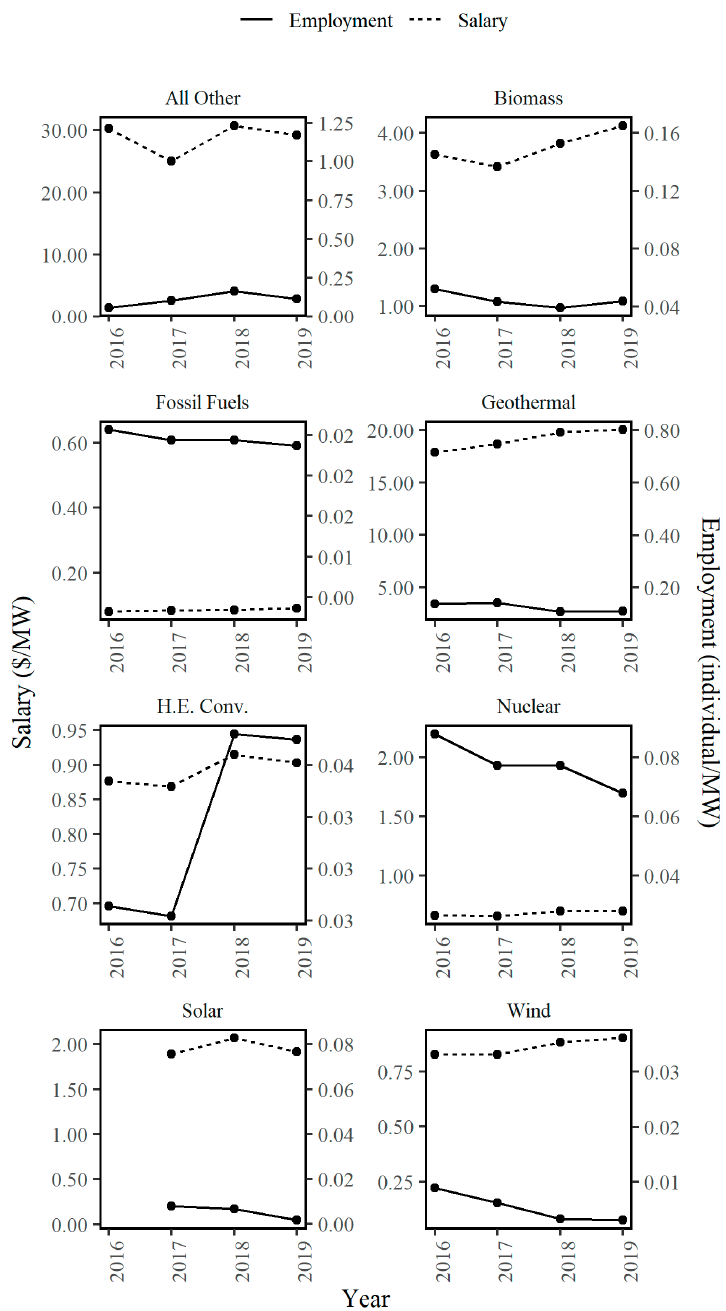
Figure 6. Rate of plant operators employed and mean annual pay per MW of energy source generator nameplate capacity 2016–2019. Fossil fuel includes petroleum, coal, natural gas and other gases. All other electric power generation includes batteries, hydrogen, purchased steam, sulfur, tire-derived fuels and other miscellaneous energy sources. H.E. Conv. is conventional hydroelectric power generation. Solar includes both PV and thermal, but values do not exist before 2019, therefore 2017 and 2018 are substituted with installation, maintenance and repair occupations (SOC 49-000); in year 2016, no values were released.